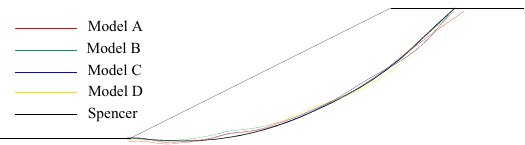
Figure 9. Critical slip surfaces based on wavelet packet and Spencer for Example 1.